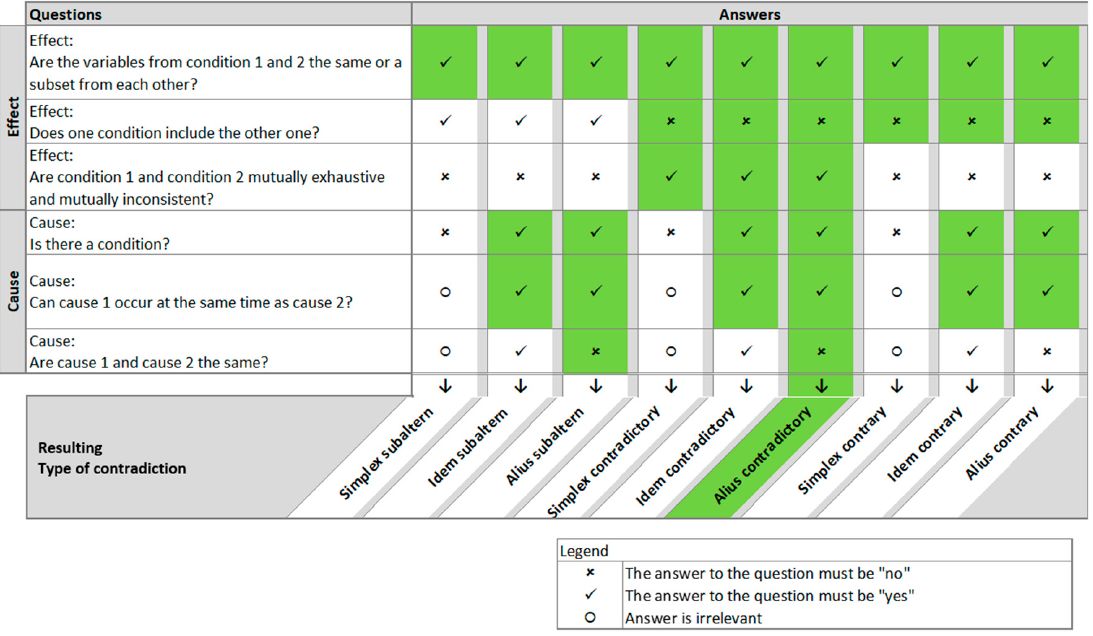
Figure 11. Process for Alius